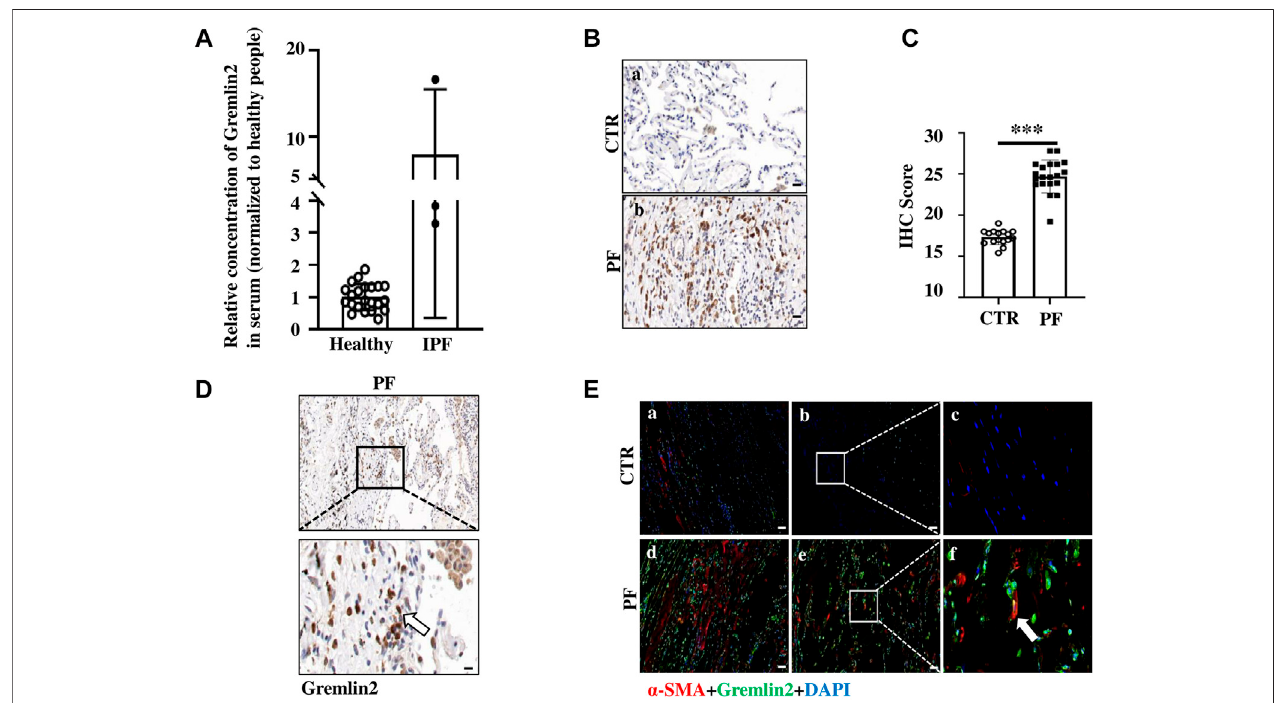
FIGURE2| Gremlin2expressionisincreasedinpatientswithIPF (A) ExpressionofGremlin2inthebloodserumdetectedusingELISA,CTR(healthycontrol) n (cid:2) 22, IPF n (cid:2) 3. (B) Representative pictures of IHC showing Gremlin2 expression in the lung tissue. Scale Bar (cid:2) 50 μ m. (C) IHC score of patients via immunohistochemical staining grading, CTR (normal) n (cid:2) 16, PF n (cid:2) 20, *** p < 0.001, paired t-test. (D) Representative photos of Gremlin2 immunohistochemical staining in the fi brotic lung tissue samples of the patient. Lower graph shows the strong positive area of Gremlin2 magni fi ed from upper graph, white arrow shows the strong positive cells of Gremlin2. Scale Bar (cid:2) 20 μ m. (E) Gremlin2 was co-localized with α -SMA in fi brotic foci. Representative images of immuno fl uorescence detection for α -SMA (red) and gremlin2 (green), and merged (yellow) images of normal subjects and patients with IPF. Graph (2Ea – c) showed the pulmonary tissue in the fi brotic area of normal lung tissuesnearthe fi broticareaofpatientswithIPF;graph (2Ed,e) ,fshowedthe fi broticlungtissueofpatientswithIPF;graph (2Ec,f) showedthelocallyenlargedviewinthe white box in graph (2Eb,e) ; white arrow points to the cells with high co-expression of α -SMA and Gremlin2. CTR is the normal tissue around the pulmonary tissue of patients with fi brosis, and PF is the lung tissue section of patients with lung fi brosis. Scale Bar (cid:2) 50 μ m. NS stands for p > 0.05, * p < 0.05, ** p < 0.01, *** p < 0.001. Student ’ s t-test was used for